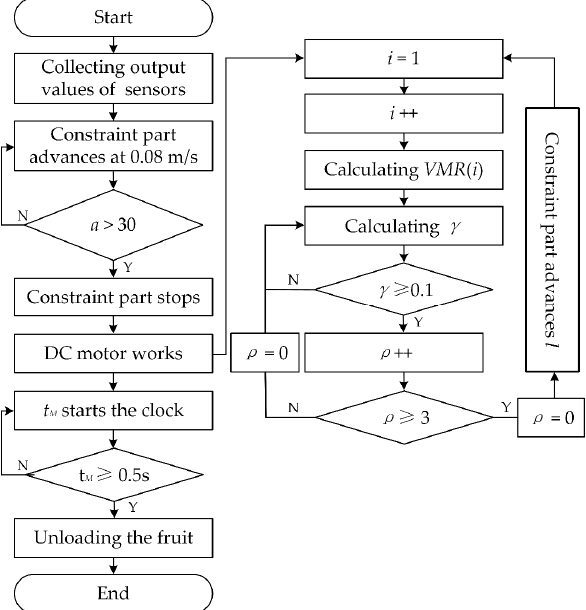
Figure 14. Flow chart of control algorithm.